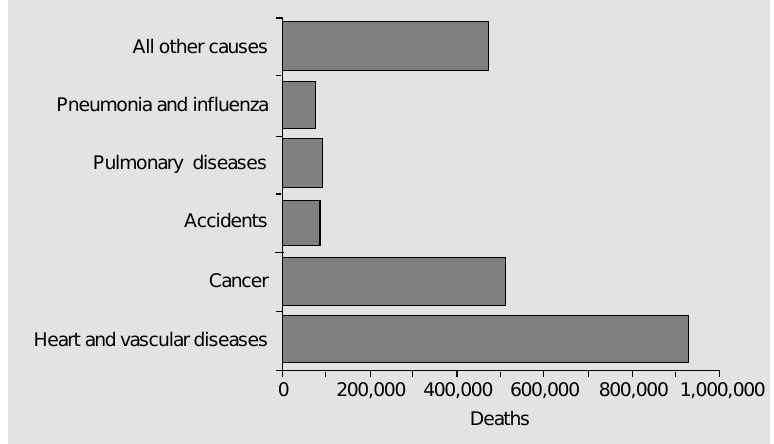
Figure 1. Causes of death in the US. Data from the American Heart Association (1993).